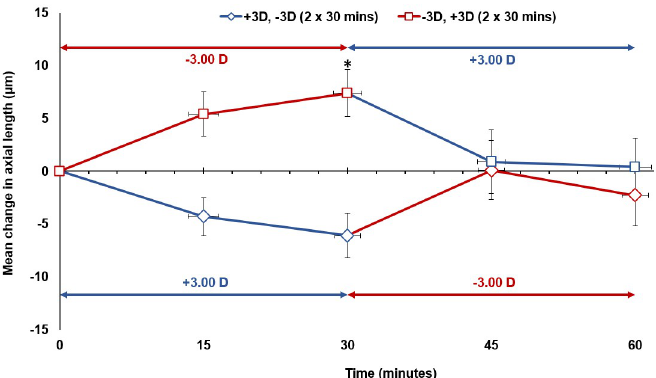
Fig 4. The mean change in axial length from baseline (0 minute time point) during 30 minute alternating cycles of hyperopic then myopic defocus (Condition C), and myopic then hyperopic defocus (Condition D) for all subjects. Vertical error bars represent the standard error of the mean difference in axial length, and horizontal error bars represent the standard error in measurement time. Asterisks indicate a significant mean difference from the baseline axial length (p <